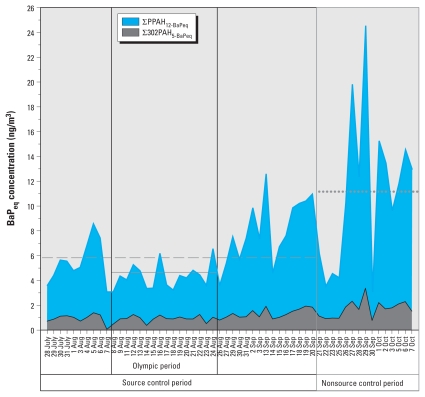
Temporal variation of ∑PPAH12-BaPeq and ∑302PAH5-BaPeq. Horizontal lines show ∑PAH17-BaPeq during the source control period (dashed line), the nonsource control period (dotted line), and the Olympic period (solid line). The figure excludes 4–12 September 2008 because of sampler motor failure.